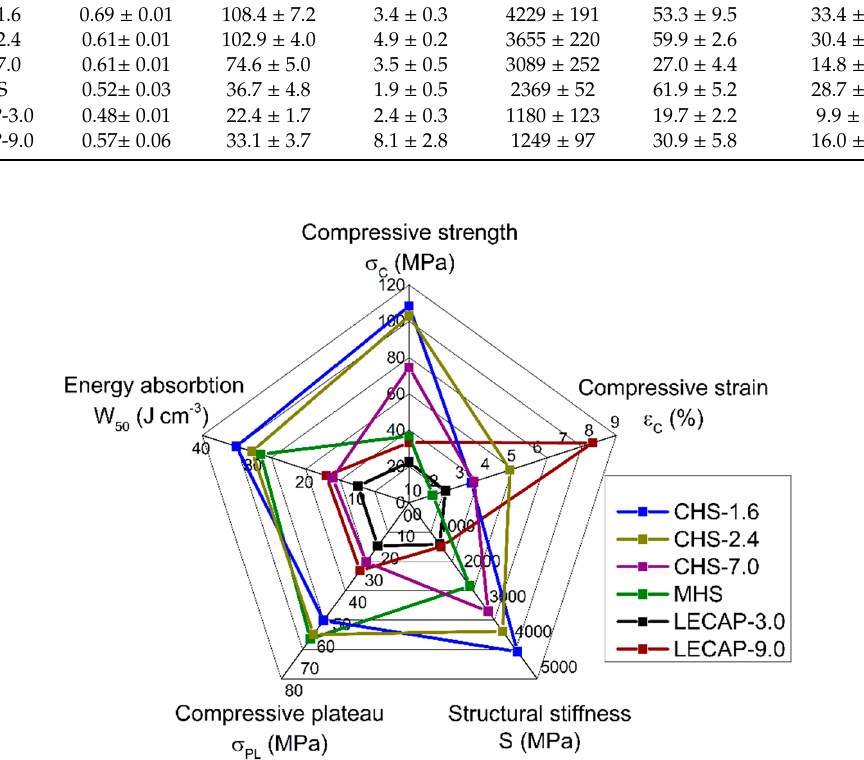
Figure 6. Radar plot of the most important properties of the foams produced with the investigated filler filler materials.